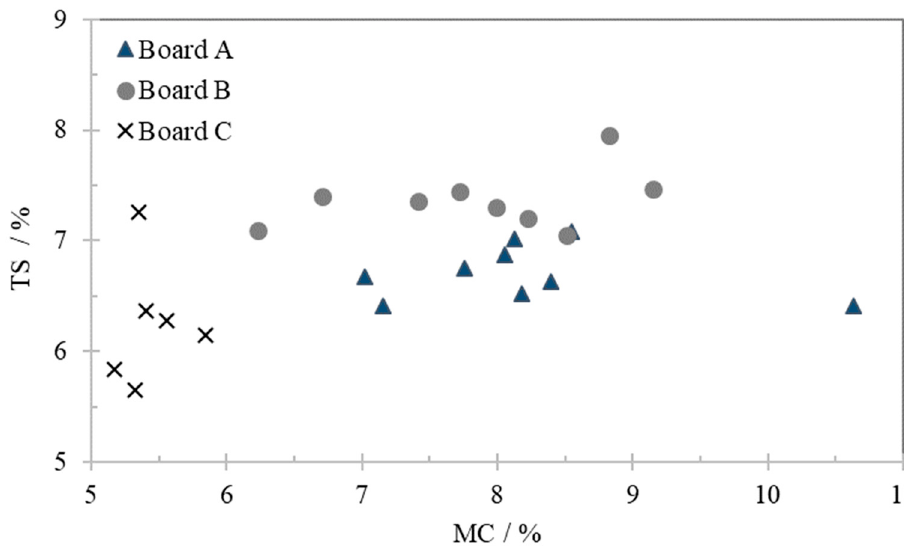
Figure 1. Thickness swelling dependence on moisture content for samples stored at room temperature and relative